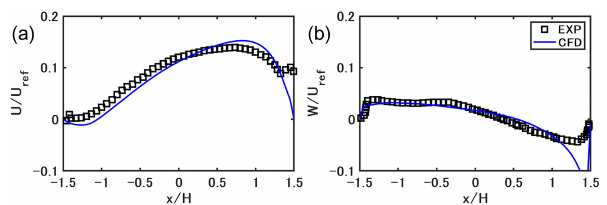
Figure B2. Streamwise and vertical direction of mean wind veloc- ities at z/H = 0 .